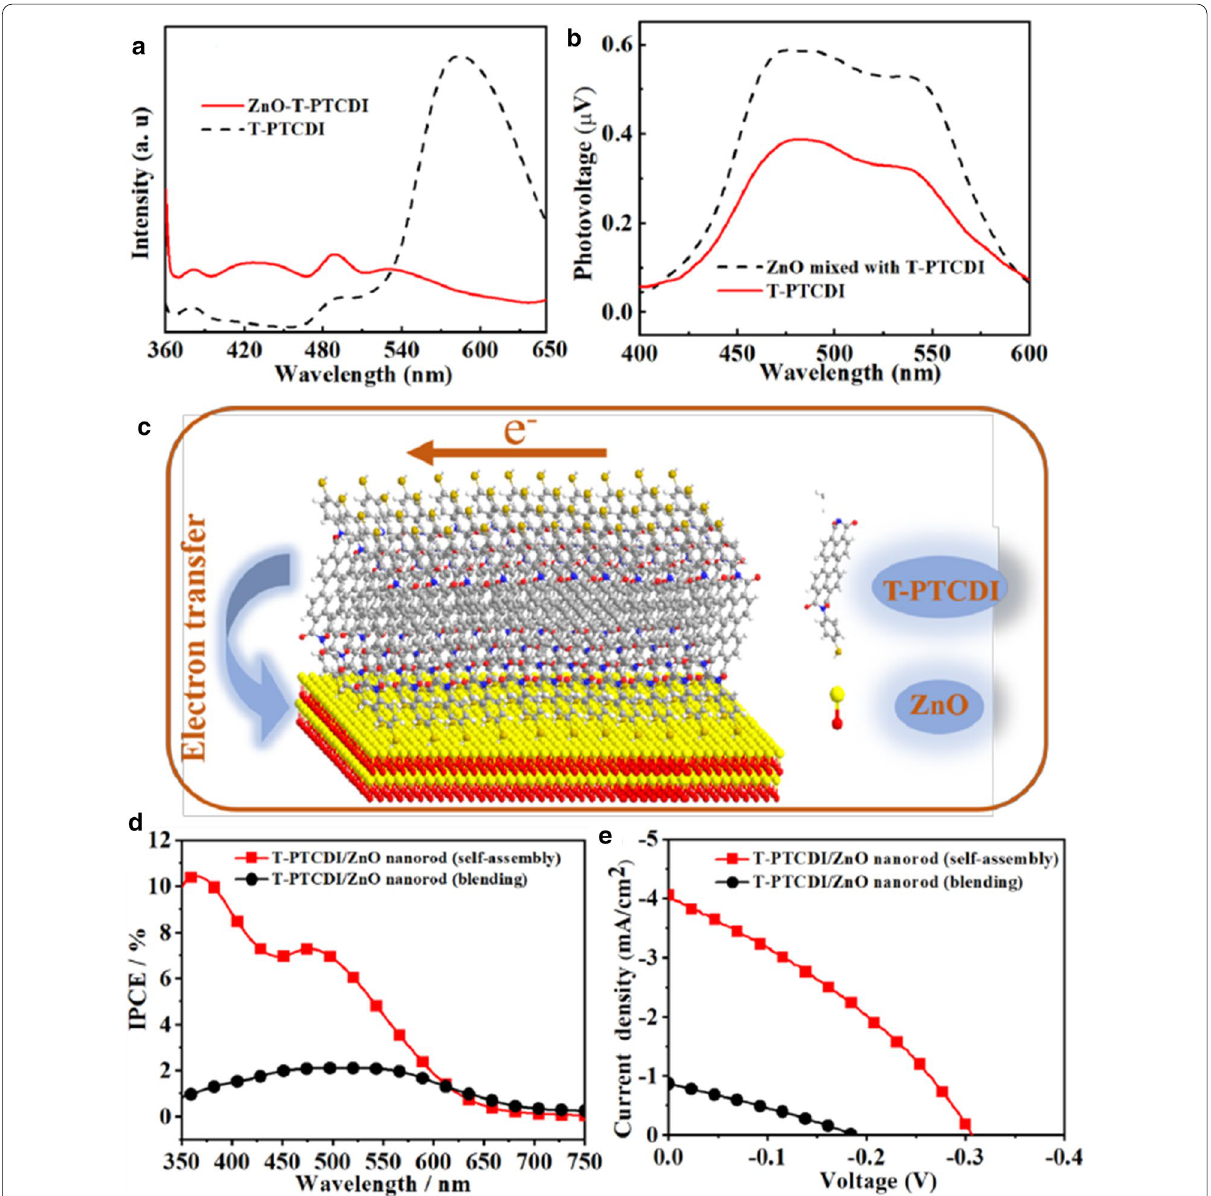
Fig. 5 a Comparison of fluorescence spectra of T-PTCDI and ZnO-T-PTCDI (excitation wavelength of 325 nm) and b SPS spectrum of ZnO in ZnO/T-PTCDI blend system. c The sketch of molecules self-assembly and charge-transfer mechanism of T-PTCDI/ZnO nanorod composites.